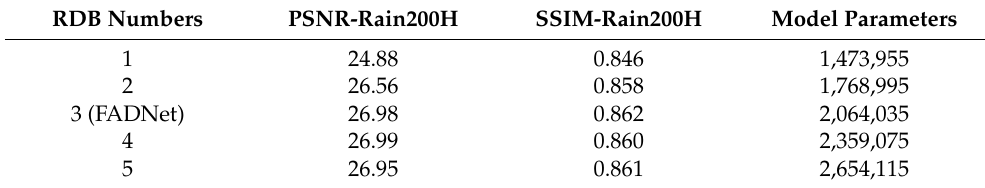
Table 3. Results of the ablation experiment for numbers of